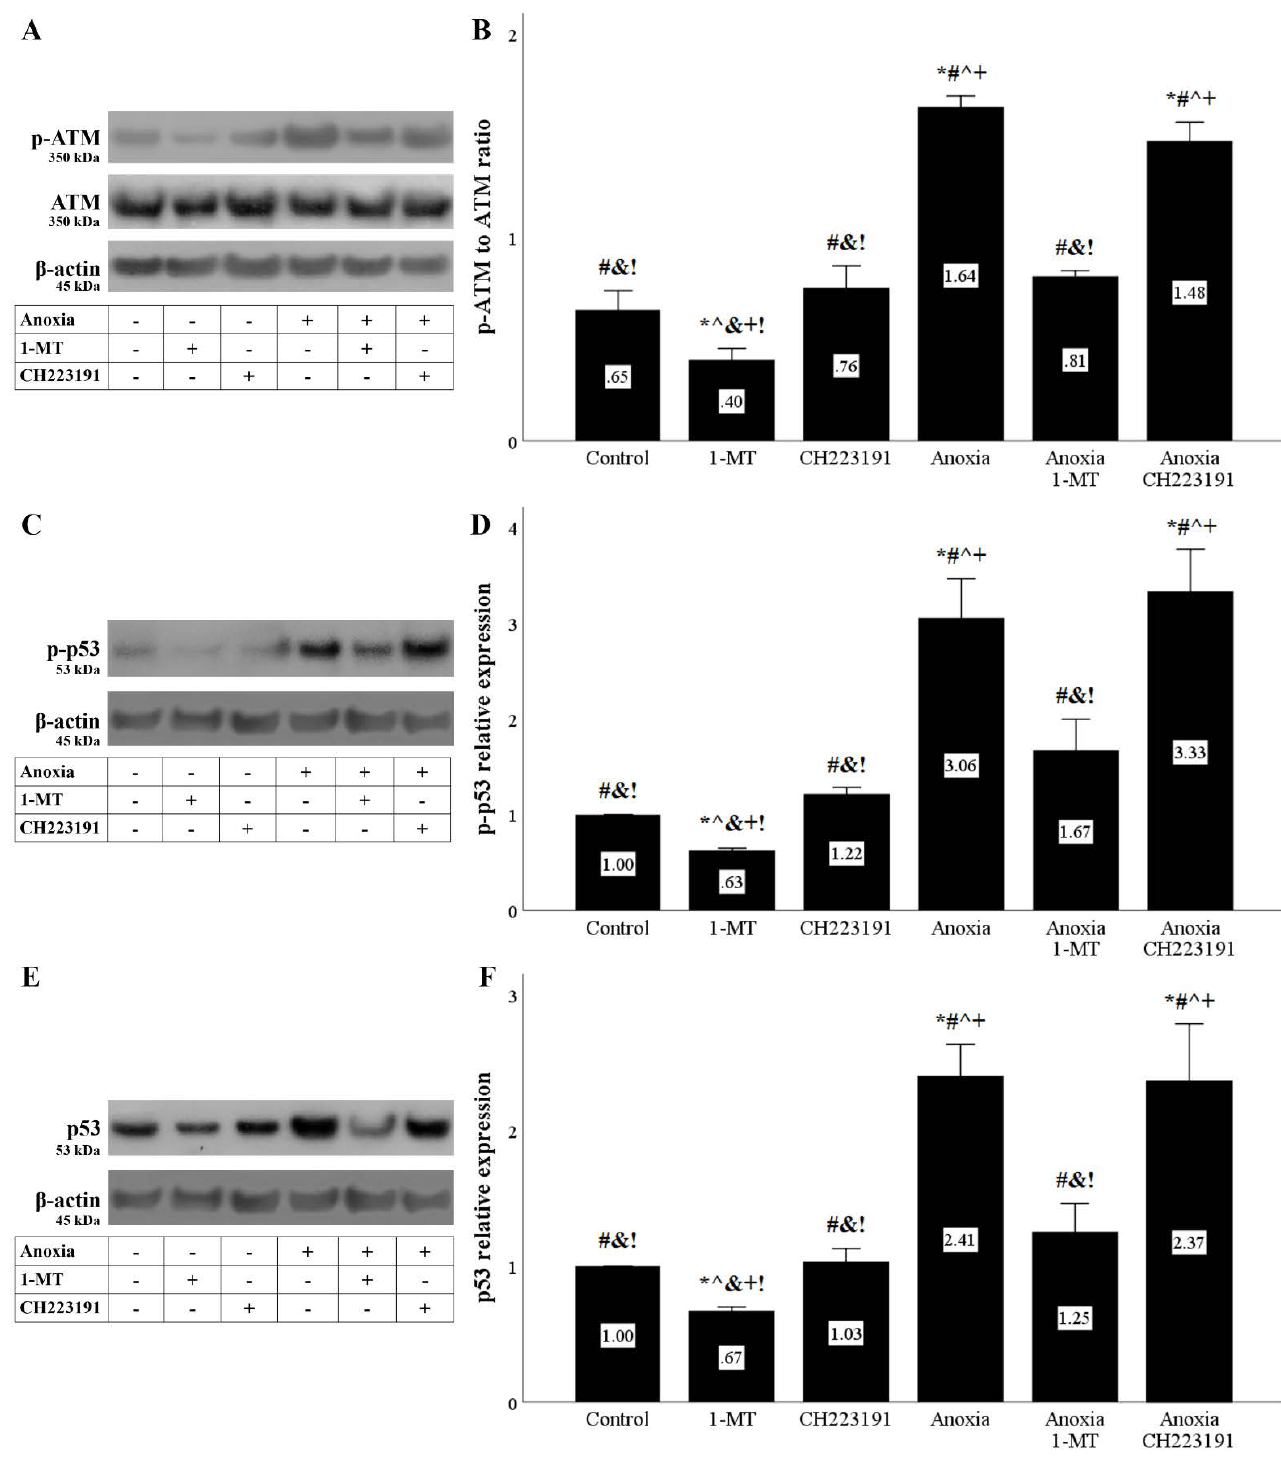
Figure 5. Anoxia induces DNA damage response that is ameliorated by inhibition of IDO. Cells were cultured under anoxic conditions for 24 h along with the indicating treatments. Anoxia induced a DNA damage response assessed by the level of phosphorylated activated ATM. 1-MT, but not CH223191, prevented p-ATM upregulation. A representative Western blot experiment is displayed in panel ( A ), whereas panel ( B ) depicts the cumulative results of four repeated experiments. Anoxia increased p-p53 level. 1-MT, but not CH223191, prevented p-p53 increase. A representative Western blot experiment is displayed in panel ( C ), whereas panel ( D ) depicts the cumulative results of four repeated experiments. Anoxia increased p53 level. 1-MT, but not CH223191, prevented p53 rise. A representative Western blot experiment is displayed in panel ( E ), whereas panel ( F ) depicts the cumulative results of four repeated experiments. * p < 0.05 vs. Control, # p < 0.05 vs. Control with 1-MT, ^ p < 0.05 vs. Control with CH223191, & p < 0.05 vs. Anoxia, + p < 0.05 vs. Anoxia with 1-